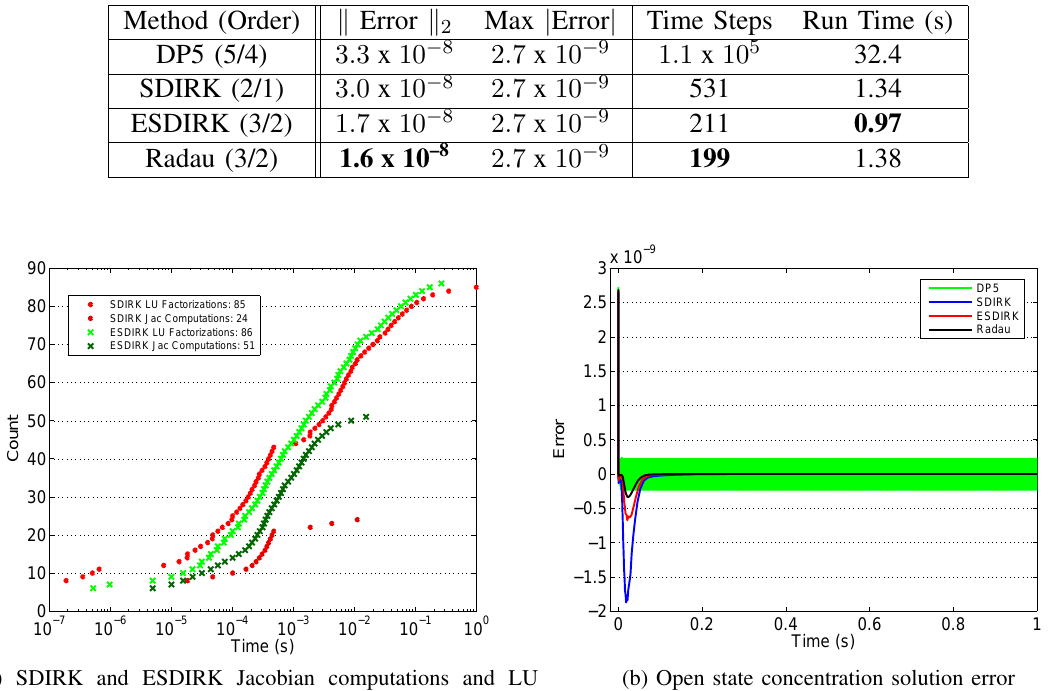
Fig. 9: Method comparison when solving the AMPAR model. V: Number of rejected and